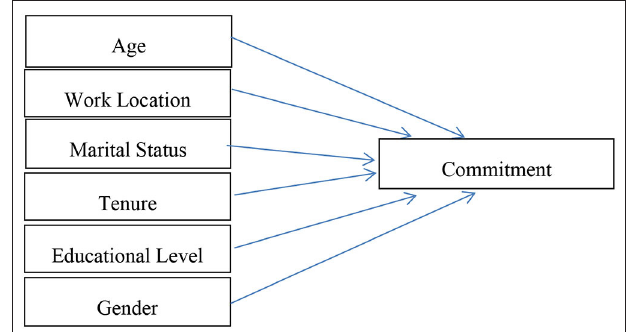
FIGURE 1 | Theoretical